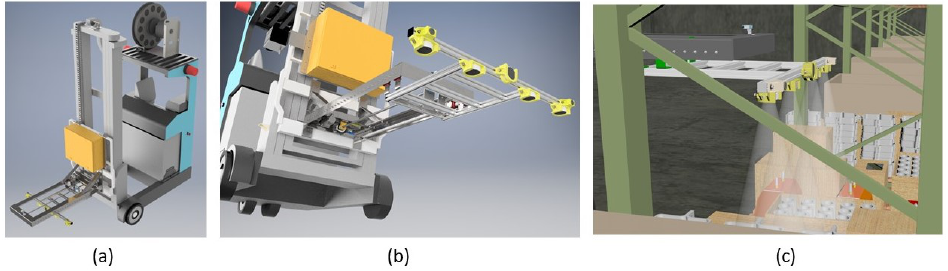
Figure 1. AGV with retractable robotic arm: ( a ) overview; ( b ) fully extended arm and ( c ) LiDARs capturing images.